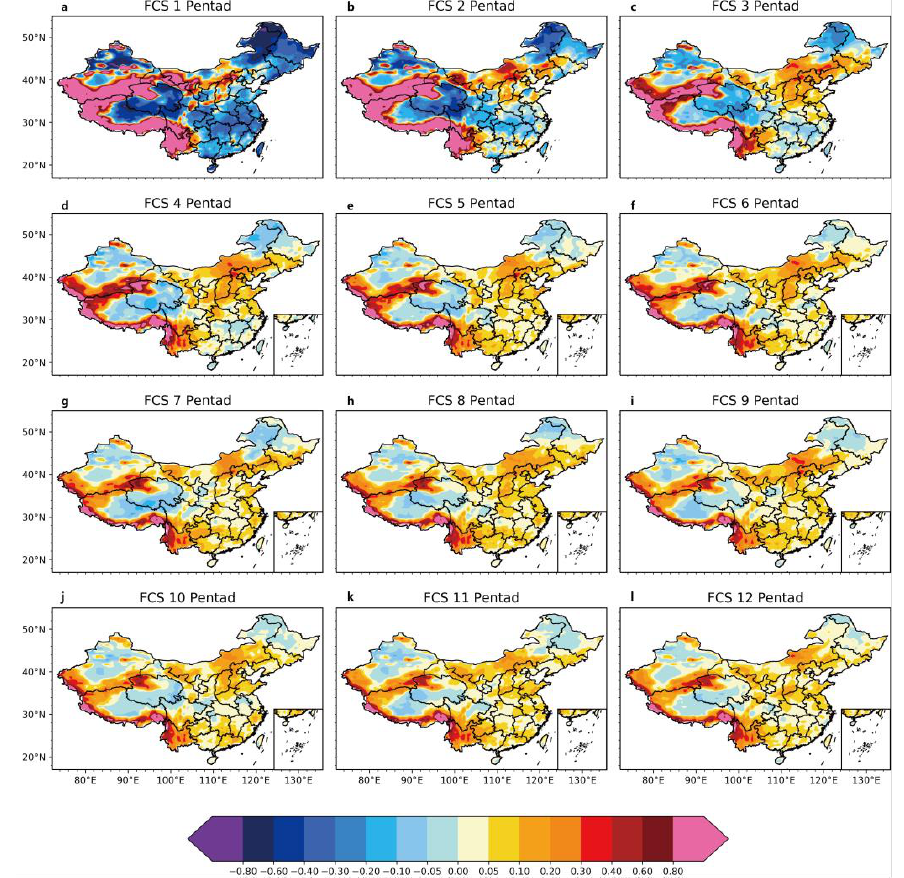
Figure 11. Spatial pattern of the annual average MSSS differences (pentad DSDM minus FGOALS- f2) between the pentad DSDM and the FGOALS-f2 model for the 1–12 ( a – l , respectively) pentad precipitation forecast from 2000 to 2018.